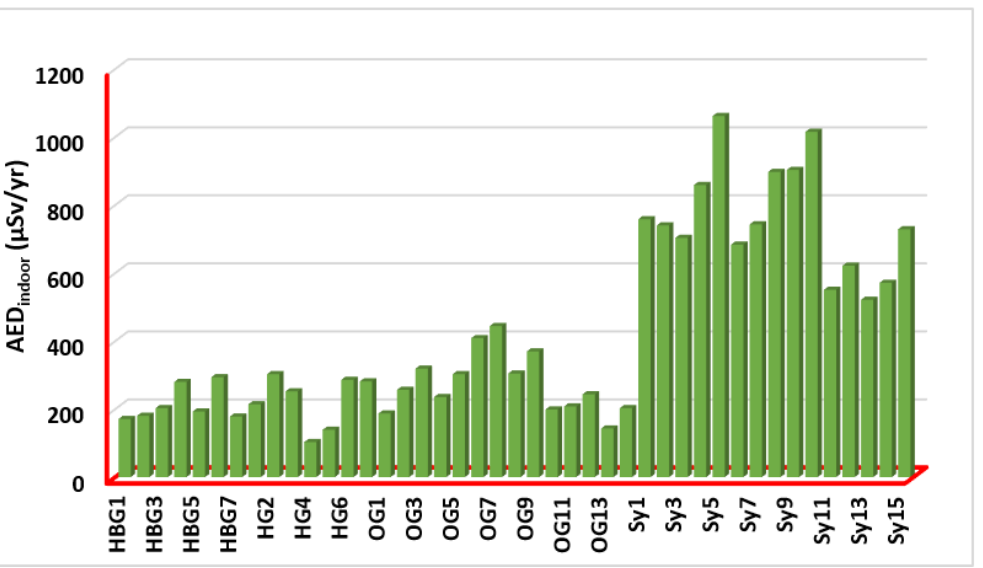
Figure 7. Indoor annual effective doses (AED outdoor ) for all (7 hornblende biotite gneisses; 7 biotite gneisses; 14 older granites; and 15 syenogranites) rock samples.